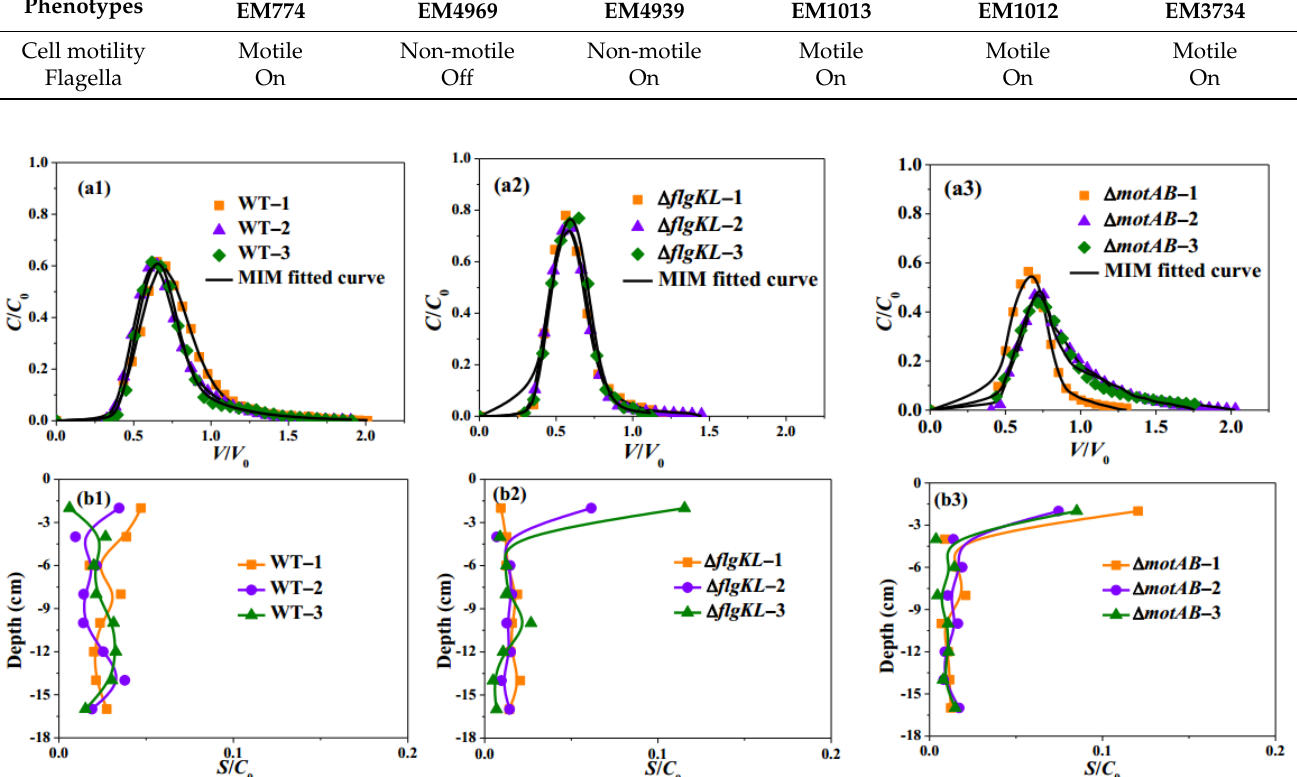
Figure 1. ( a1 – a3 ) Observed (symbols) and fitted (lines) breakthrough curves (BTCs); ( b1 – b3 ) Observed retention profiles (RPs) of S. Typhimurium WT motile flagella-on, Δ flgKL non-motile flagella-off, and Δ motAB non-motile flagella-on mutants . V is the volume occupied by water in the column, V 0 is the total pore volume of the column, and C , C 0 , and S are the time-dependent, initial, and solid phase concentration of bacteria respectively.